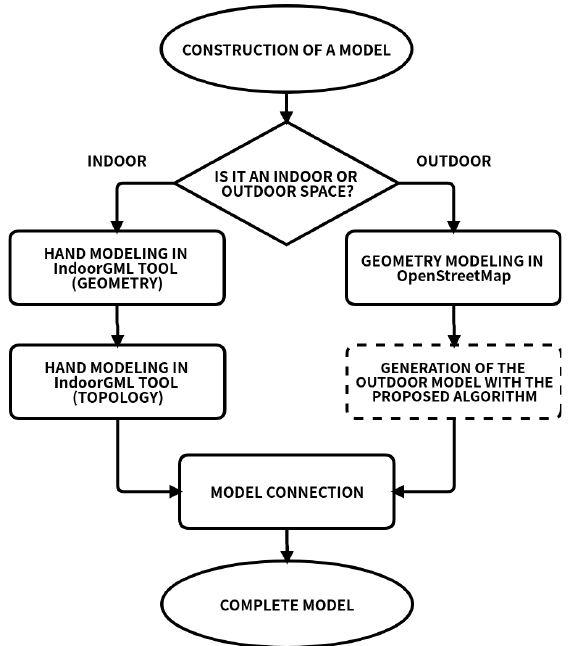
Figure 2. General process to obtain a comprehensive indoor, outdoor, or indoor– outdoor